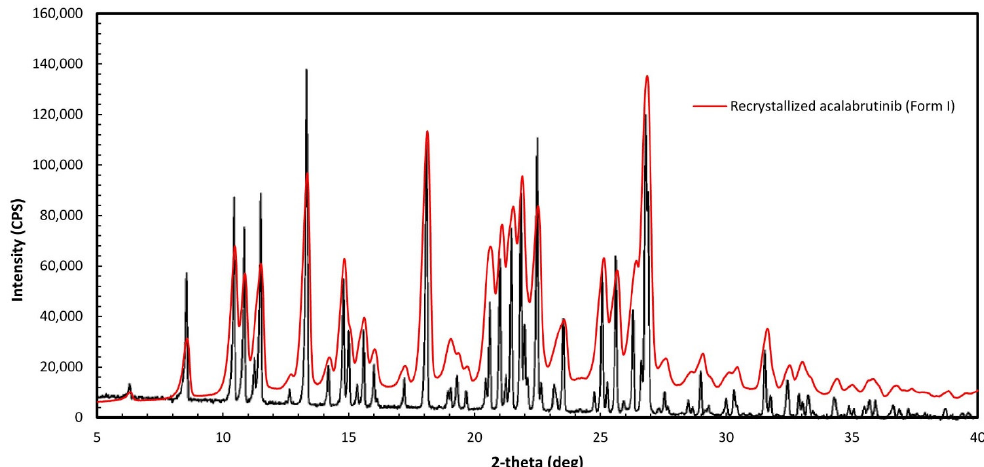
Figure A1. Overlay of recrystallized acalabrutinib and Form I as specified in Figure 1 of WO 2017/002095 Al.